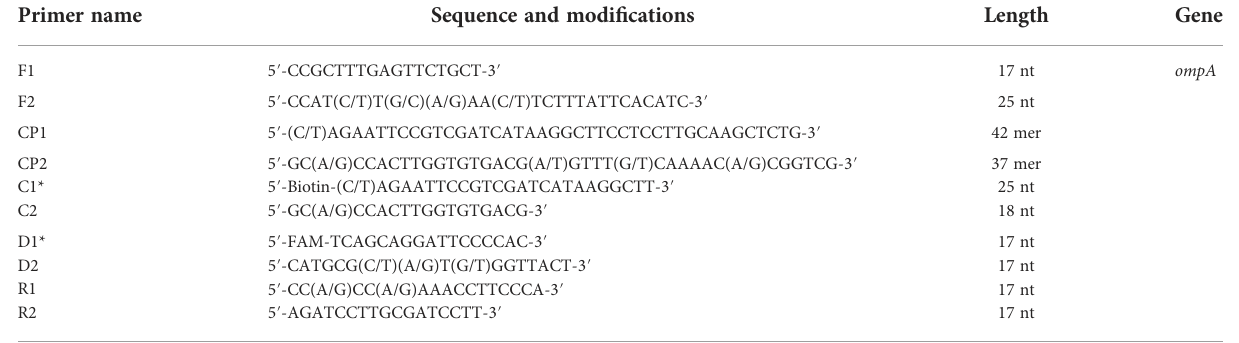
C1*, 5 ′ -labeled with biotin when used for the AuNP-LFB assay; D1*, 5 ′ -labeled with FAM when used for the AuNP-LFB assay. FAM, 6-carboxy- fl uorescein; nt, nucleotide; mer, monomeric unit.